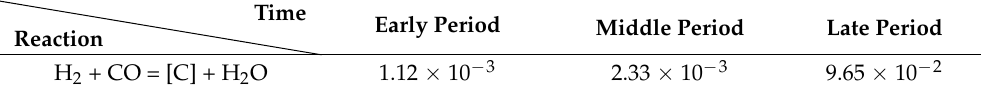
Table 14. Equilibrium partial pressure ratios of water and hydrogen for reaction H 2 + CO = [C] + H 2 O. Time Early Period Middle Reaction